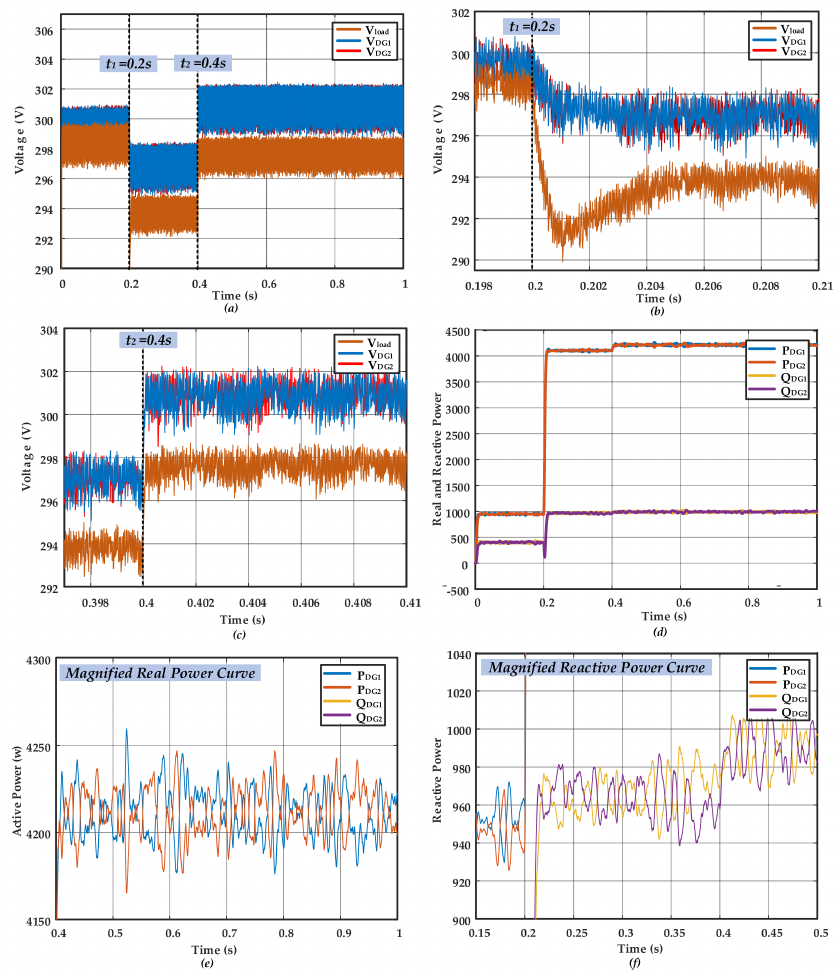
Figure 5. MATLAB/Simulink results with the conventional control scheme. ( a ) Behavior of load voltage and inverter terminal voltage. ( b ) Disturbance load jX d1 /R d1 added at t 1 . ( c ) Voltage regulation with the conventional control scheme. ( d ) Real and reactive power sharing. ( e ) Magnified active power. ( f ) Magnified reactive